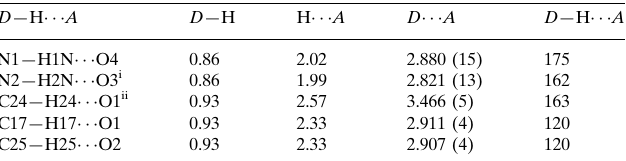
Hydrogen-bond geometry (A˚ , (cid:2)